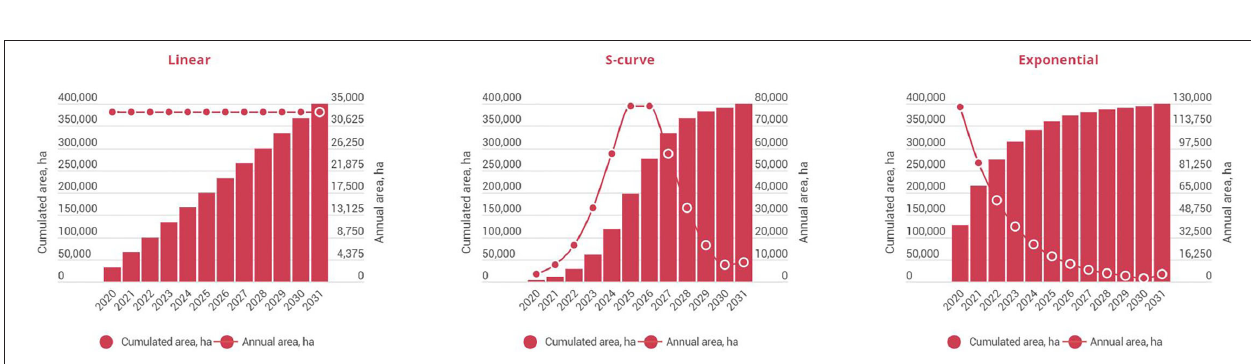
Above-Ground Biomass Default values for above-ground biomass (AGB) are estimates expressed in metric tons of dry matter per hectare (t d.m./ha), (IPCC, 2006, 2019a). The corresponding carbon stock, in metric ton of carbon per hectare (tC/ha) is calculated using the default carbon content, e.g. 0.47 for above-ground forest biomass (see Table 4.3, IPCC, 2006, 2019a) and 0.451 for mangrove forest